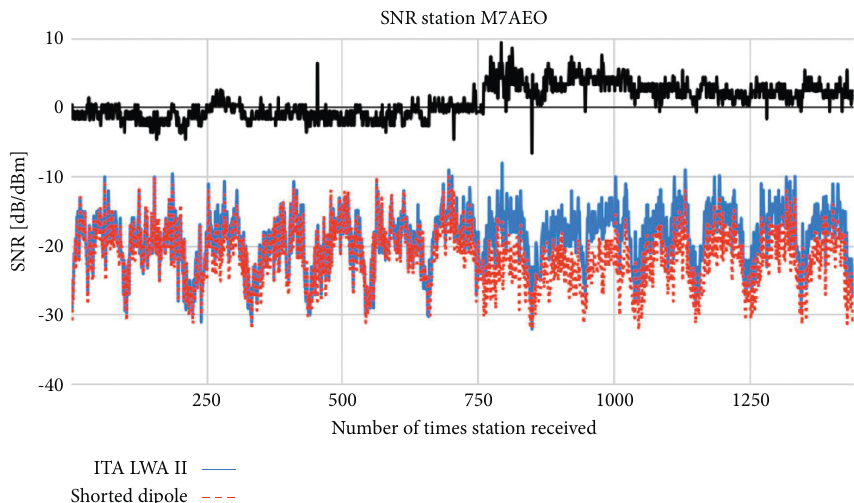
Figure 6: The SNR values of antennas for station M7AEO. The solid blue line is the ITA LWA II antenna (two weeks in the same position), and the dotted red line is the adapted shorted dipole (one week in parallel with the ITA LWA II antenna—up to measurement point 750, in the second week shifted by 90 ° in the horizontal plane—after measurement point 750). The difference between both SNR values is shown as a solid black line at the top of the chart.